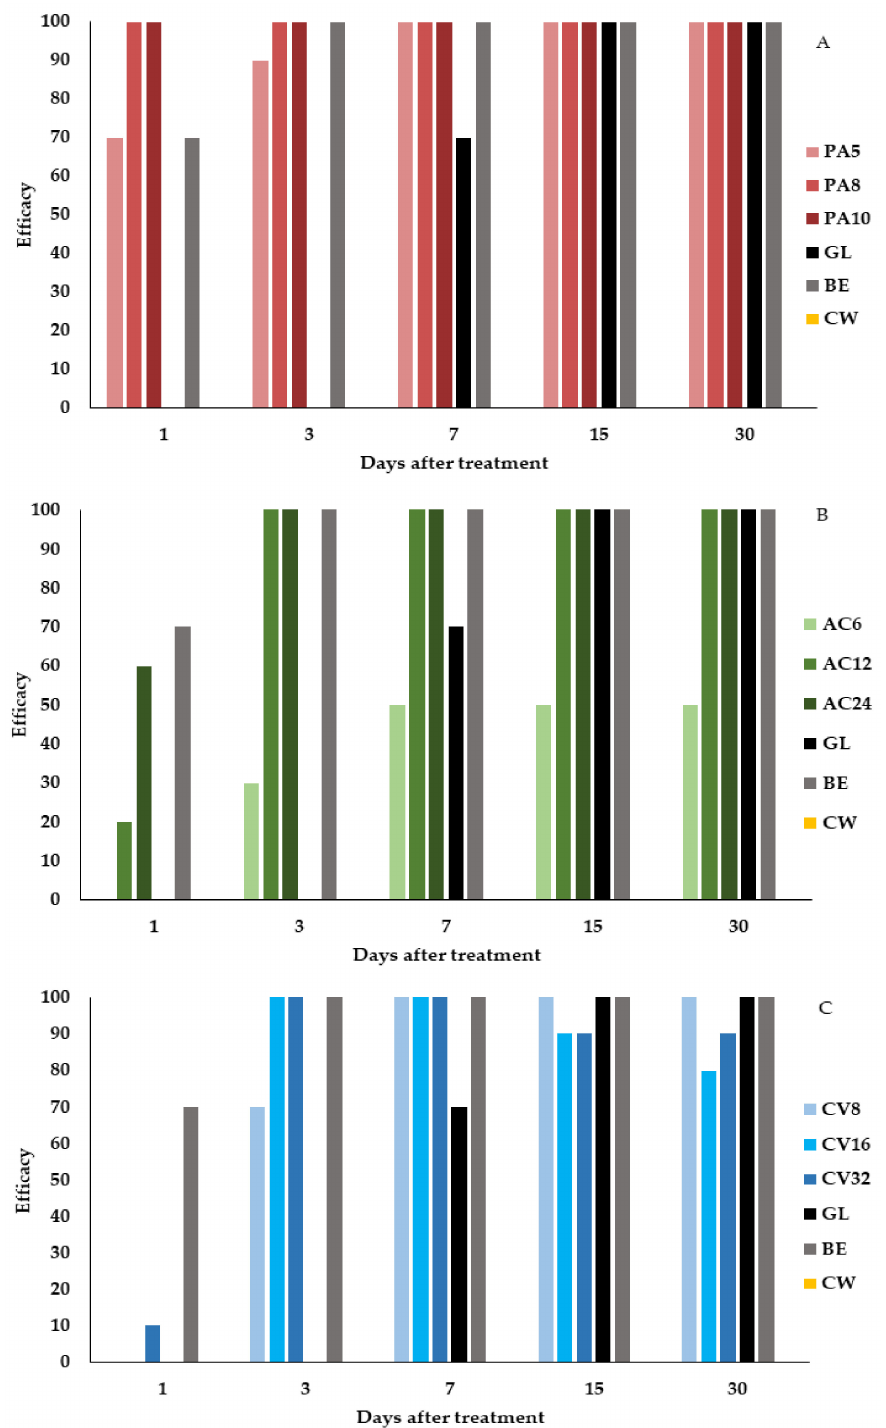
Figure 7. Evolution of e ffi cacy of the tested treatments ( A ) pelargonic acid, ( B ) cinnamic aldehyde, and ( C ) carvacrol in P. oleracea during 30 days after their